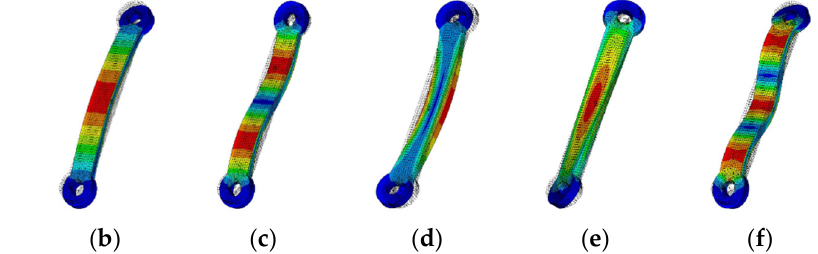
Figure 14. Finite element model of flexible auxiliary rod and modal diagrams of the first five modes: ( a ) finite element model; ( b – f ) first to fifth modes.